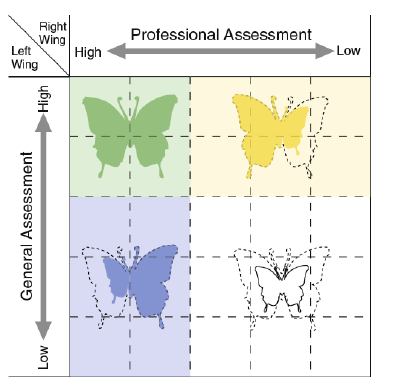
Figure 6. Analysis of built heritage architecture using the “Heritage Butterfly” model (Muramatsu et all. 2009)